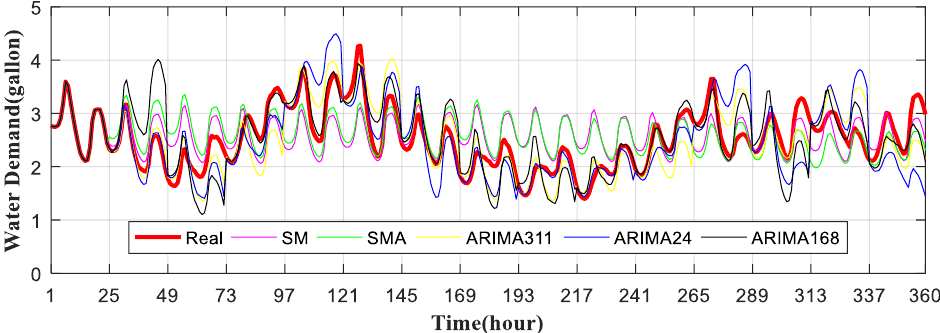
Figure 6. Forecast of water demand with different methods targeting data from GEFCom2014.